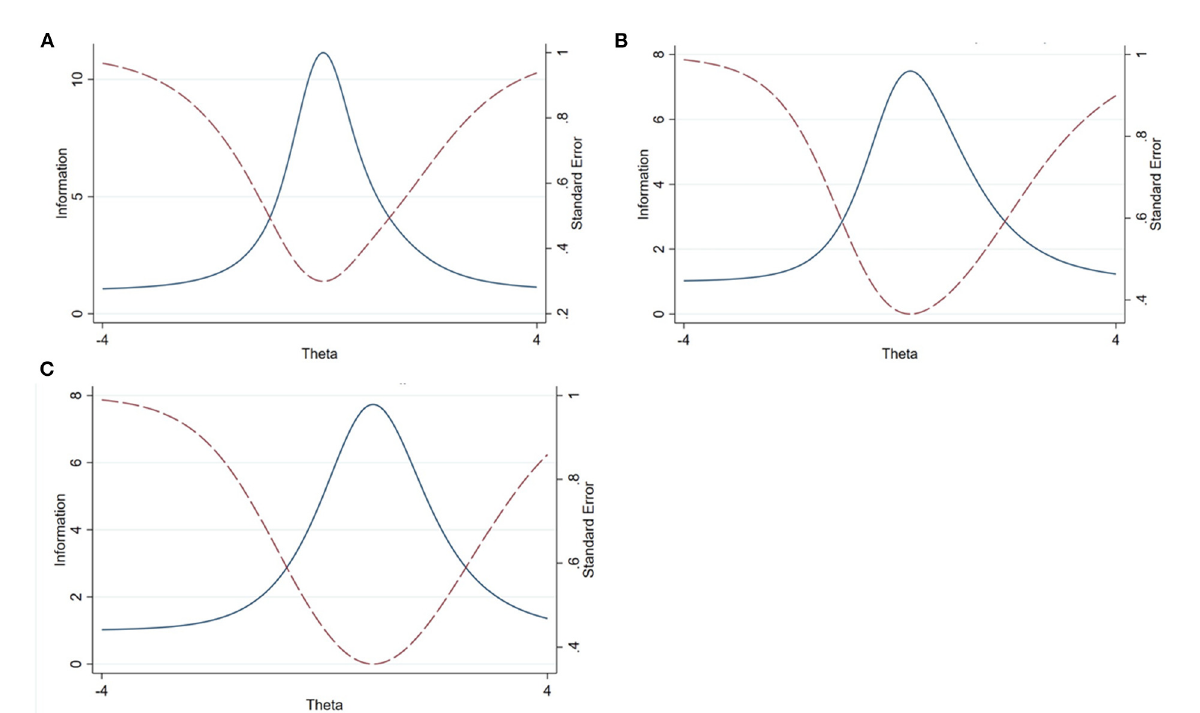
FIGURE3 Test information function for animal welfare knowledge (A) , attitude (B) , and practice (C) scale. Blue line indicates “Test information” and red dot line indicate “Standard error.” The questions provided maximum information for respondents with knowledge level between − 1 to 1.5, attitude level between − 1 to 2 and practice level of − 0.5 to